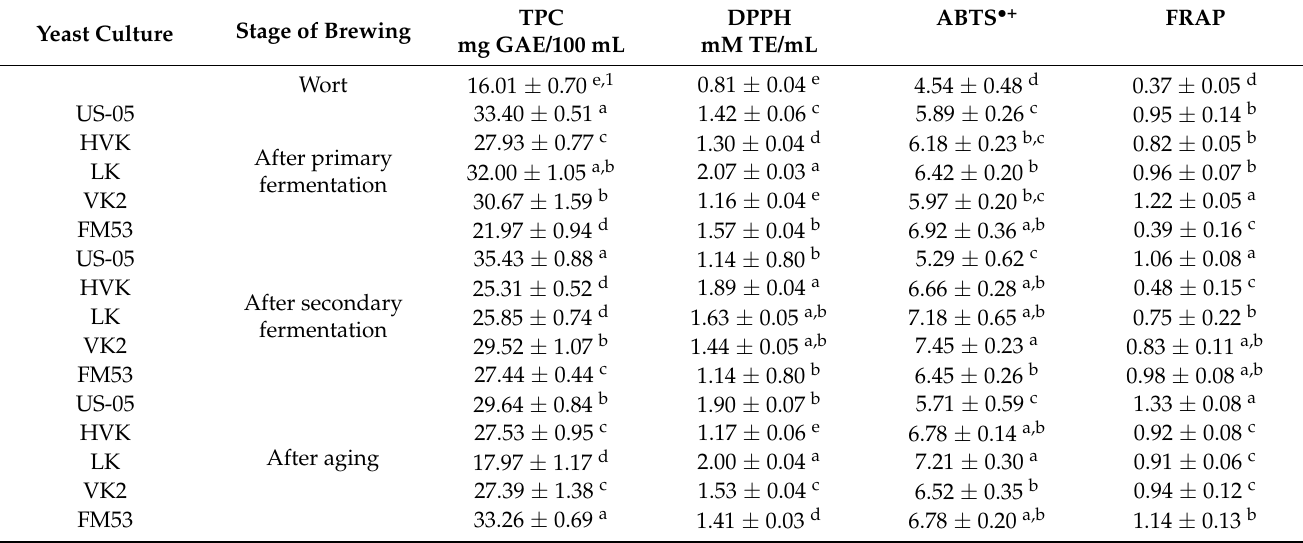
Table 3. Total phenolics content (TPC) and antioxidative activity of the